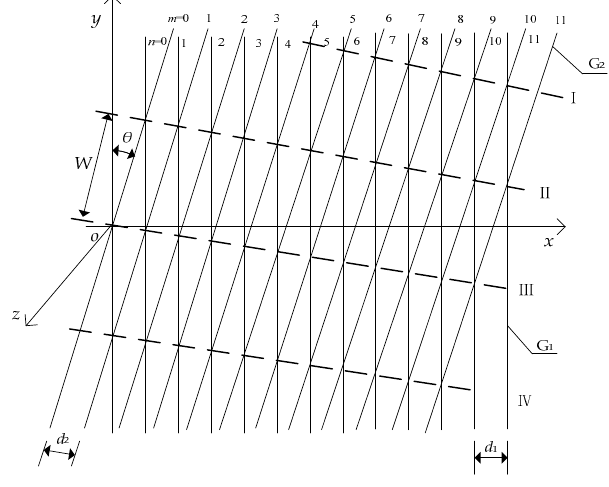
Figure 2. Moiré fringe coordinate system.